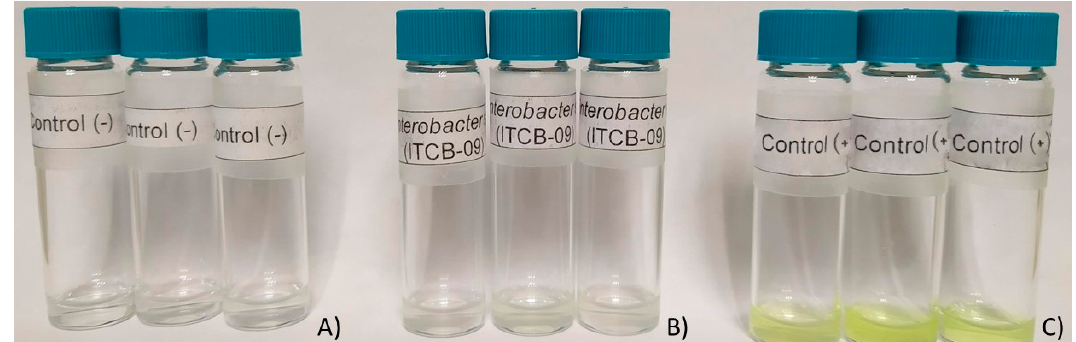
Figure 4. Results of phosphatase activity assay. ( A ) Negative control; ( B ) Enterobacter sp. ITCB-09; ( C ) E . coli .